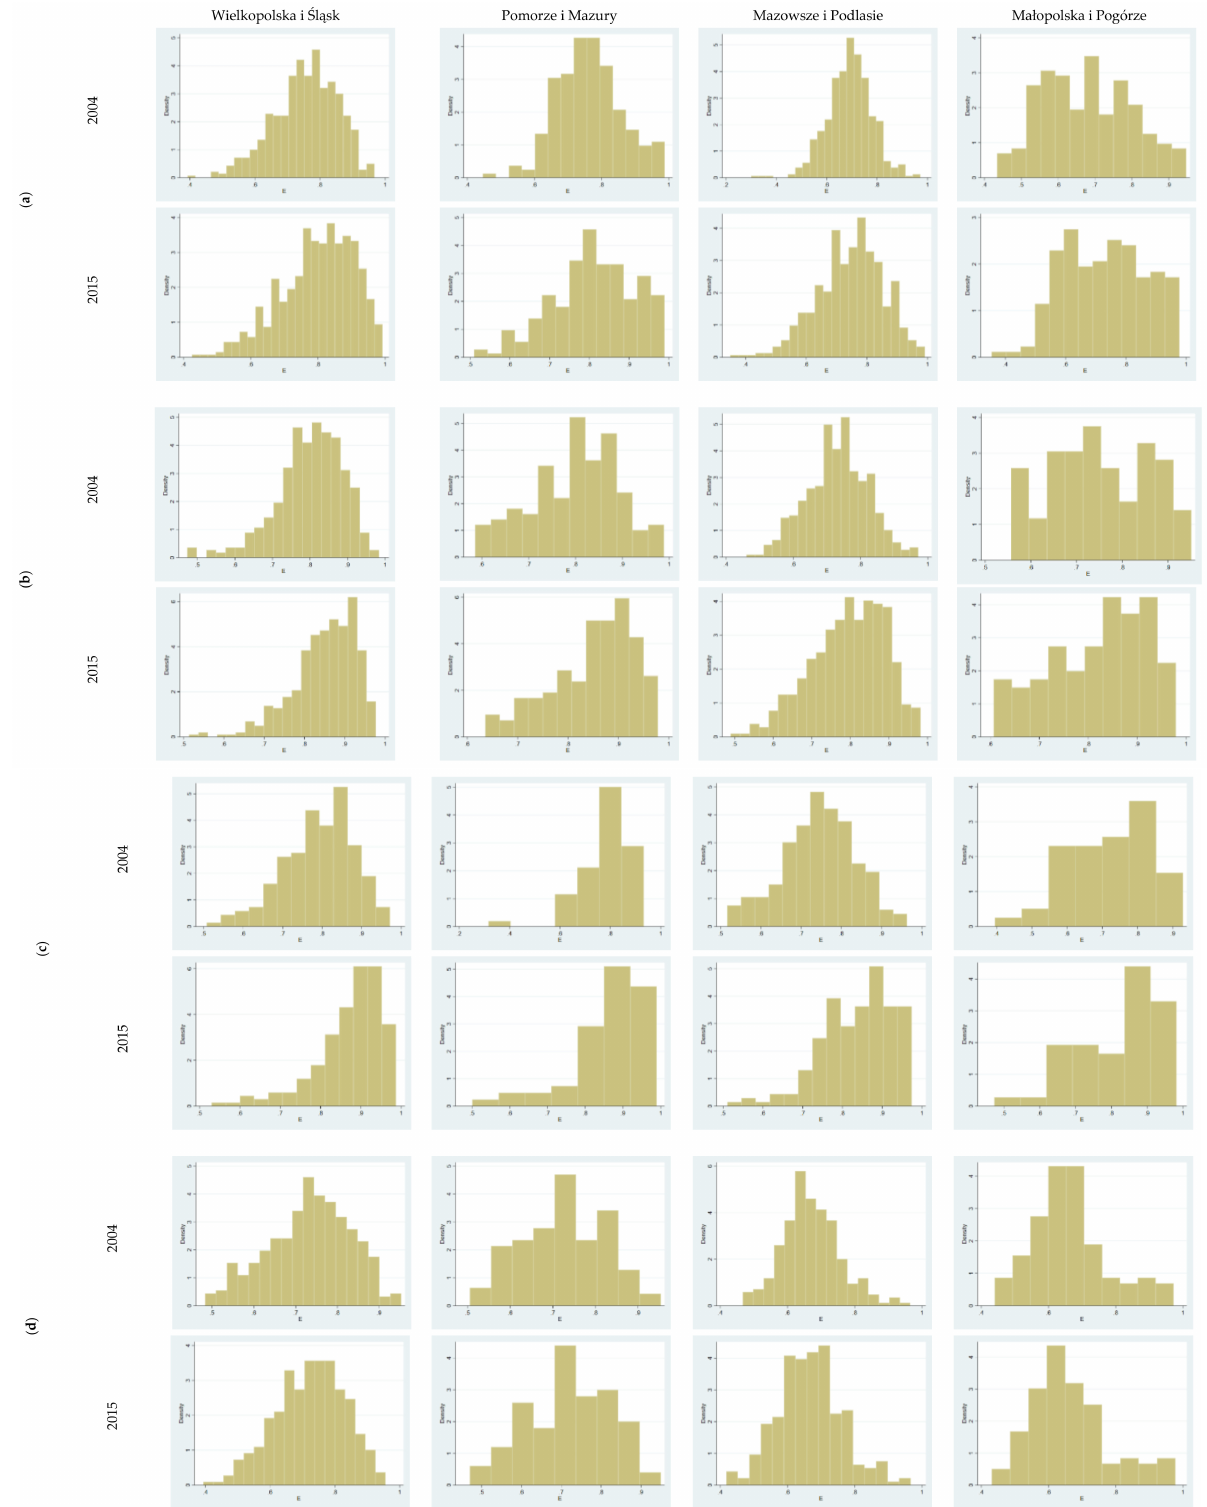
Figure 6. Changes in technical efficiency of farms in individual regions of Poland depending on the overinvestment group in 2004–2015. ( a ) optimum investment level; ( b ) absolute overinvestment; ( c ) relative overinvestment; ( d ) underinvestment. Source: own elaboration based on EU-FADN–DG